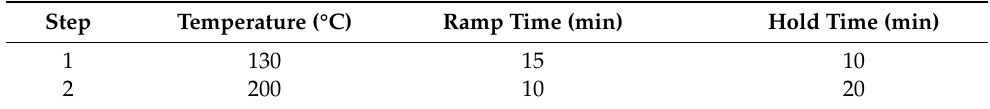
Table 1. Microwave digestion procedure.